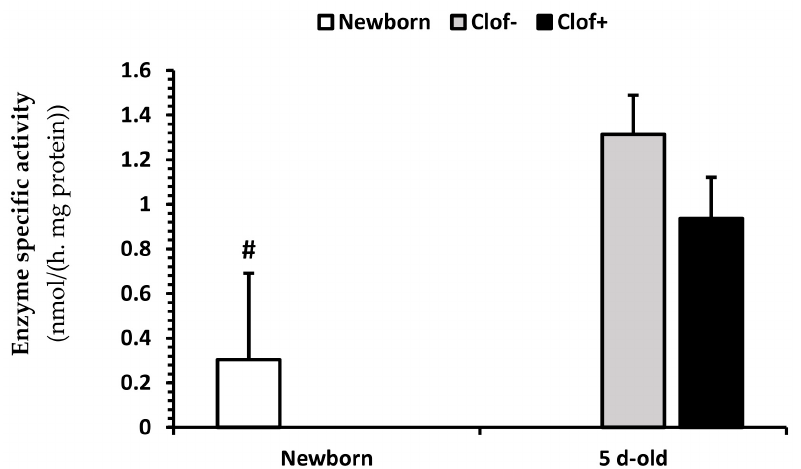
Figure 5. The effect of dietary clofibrate fed to pigs for five days on acetyl-CoA carboxylase activity. Data (Lsmeans ± SE) are specific activities (nmol/(h.mg of tissue protein)). No significant difference was observed between pigs with and without clofibrate ( p = 0.06). # The enzyme activity was on average 3.7-fold greater from 5 d-old pigs than newborn pigs ( p < 0.04).